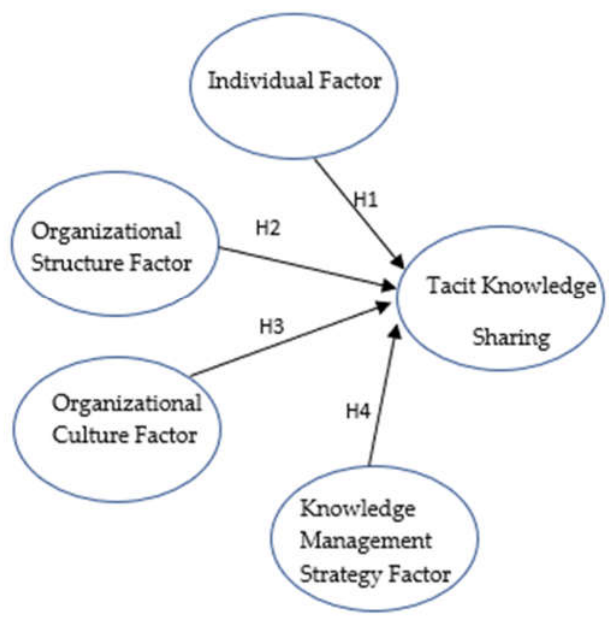
Figure 1. Research